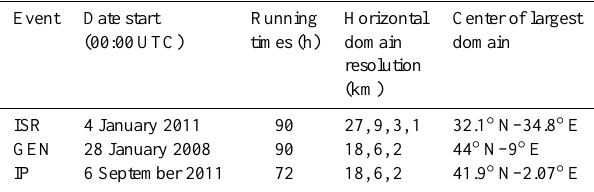
Figure 1. Location of the nocturnal coastal fronts that affected the Israeli coast (ISR) on 6 January 2011, the Gulf of Genoa (GEN) on 30 January 2008, and the northeastern coast of the Iberian Peninsula (IP) on 6 September 2011. Rectangles correspond approximately to the smallest domains used in each of the WRF-ARW simulations. Dashed rectangles indicate quasi-stationary fronts, while the closed rectangle indicates a non-stationary coastal front.